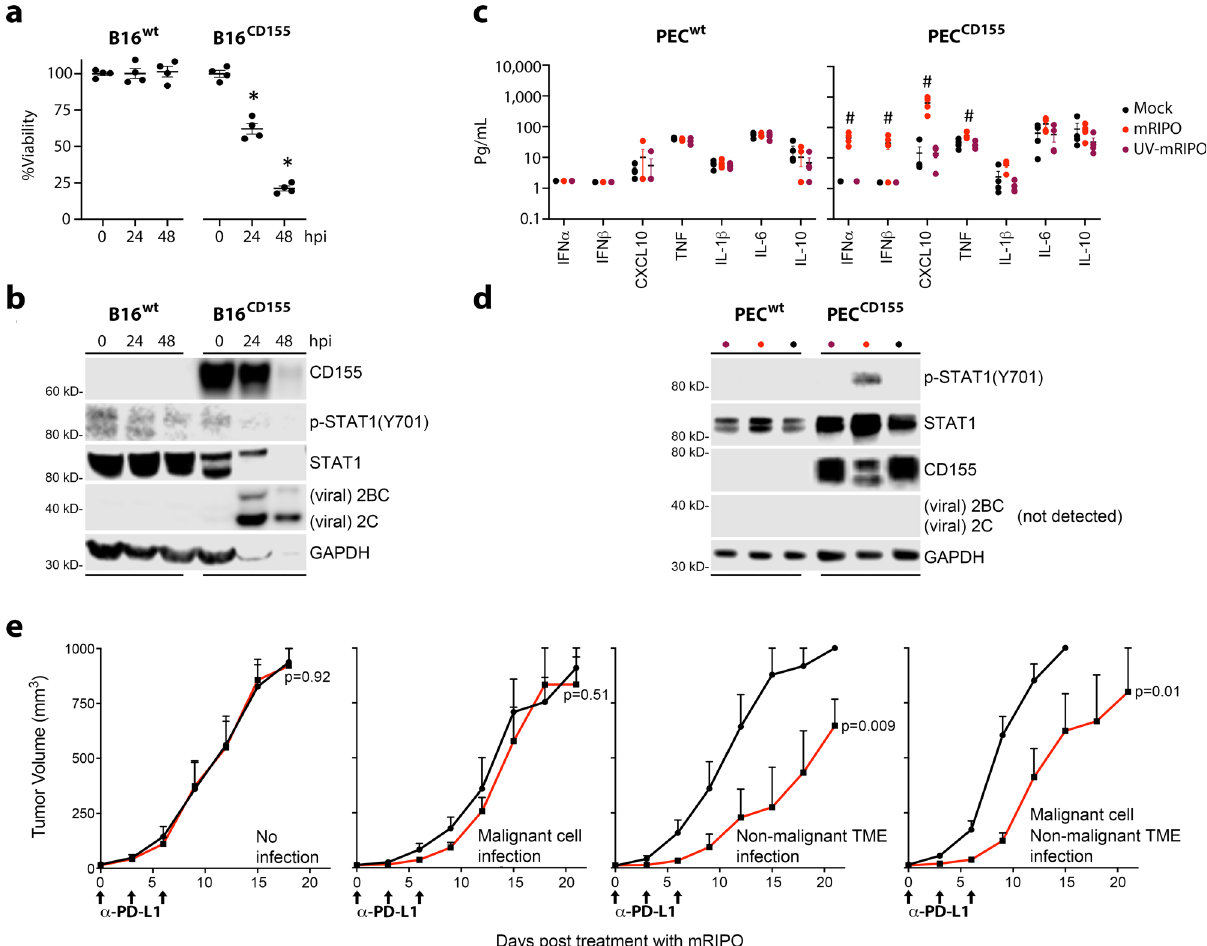
Fig. 3 The non-malignant TME mediates antitumor ef fi cacy of PVSRIPO in mice. a , b B16 WT or B16 CD155 cells were treated in vitro with mRIPO (MOI 10). Viability ( a ) was measured by WST1 assay, values were normalized to %mean “ 0 ” time point, and immunoblot analysis ( b ) of cell lysates for CD155, STAT1, and viral protein (2C, 2BC). c , d PEC from WT (PEC WT ) or CD155-tg (PEC CD155 ) mice were treated with mock, mRIPO (MOI 10), or UV-inactivated mRIPO (MOI 10 pre-inactivation titer) in vitro (48 h). Supernatant cytokines ( c ) were measured and immunoblot analysis ( d ) was performed as in ( b ). a – d n = 4 experiments, ( a , c ) mean − / + SEM are shown, symbols (* and #) denote signi fi cant Tukey ’ s post-hoc test ( p < 0.05, two-tailed) compared to “ 0 ” time point ( a , *, p < 0.0001 for both) or all other groups ( c , #). e Wt or CD155-tg B16 cells were implanted into wt or CD155-tg mice to test (left to right): no infection (wt cells & hosts, n = 6 mock, 8 mRIPO), malignant cell only infection (B16-CD155-tg, wt hosts, n = 6 mock, 8 mRIPO), TME only infection (wt cells, CD155-tg hosts, n = 7 mock, 6 mRIPO), or TME + malignant cell infection (both CD155-tg, n = 9 mock, 8 mRIPO). Mice were treated intratumor with PBS or mRIPO (1 × 10 7 pfu) on day 0; PD-L1 blocking antibody was injected i.p. in all groups as shown. Mean tumor volume (mm3) + SEM are shown at each test interval; p -values are from two-way ANOVA (two-tailed); a representative series from two experiments is